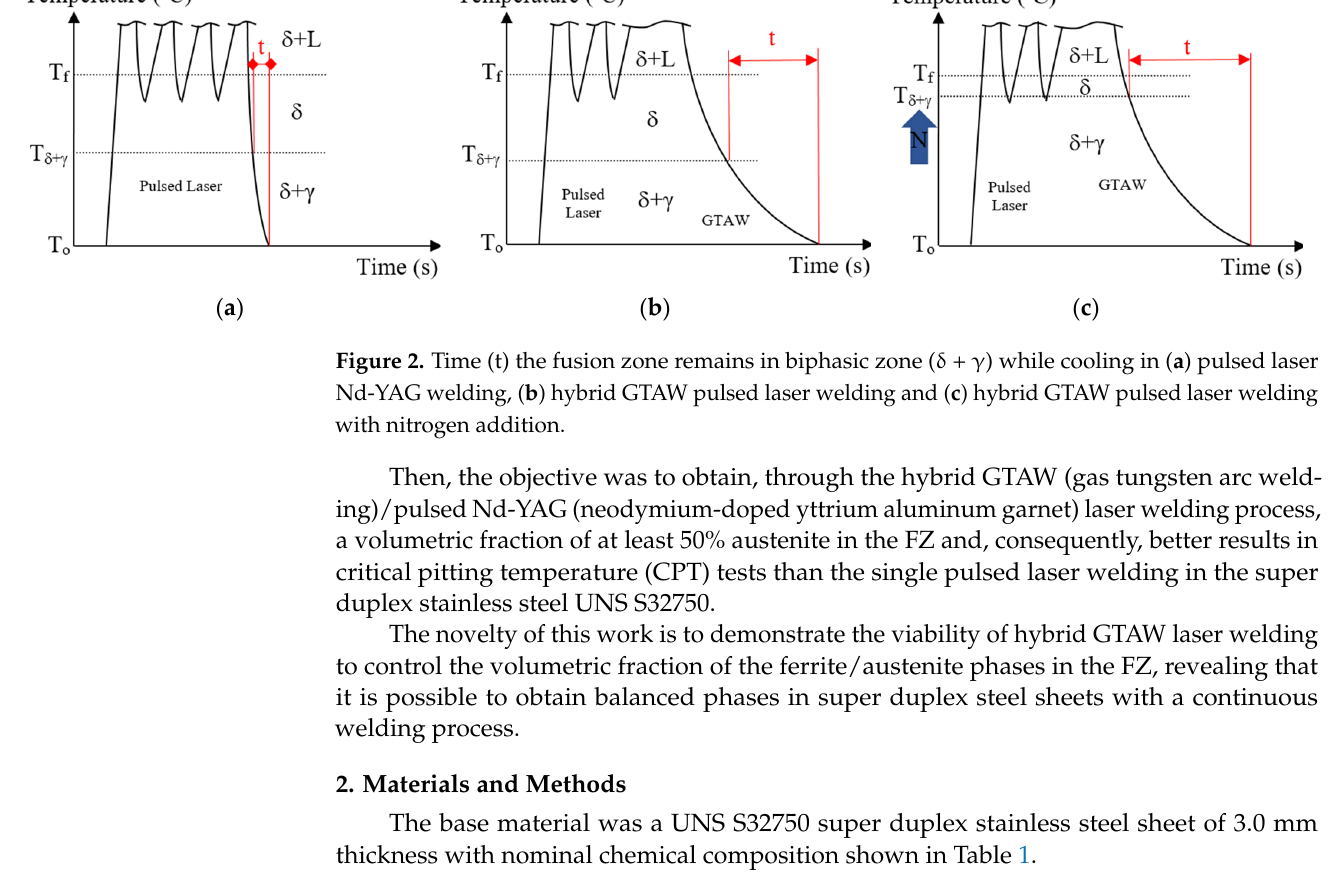
Table 1. Chemical composition of UNS S32750 super duplex steel.